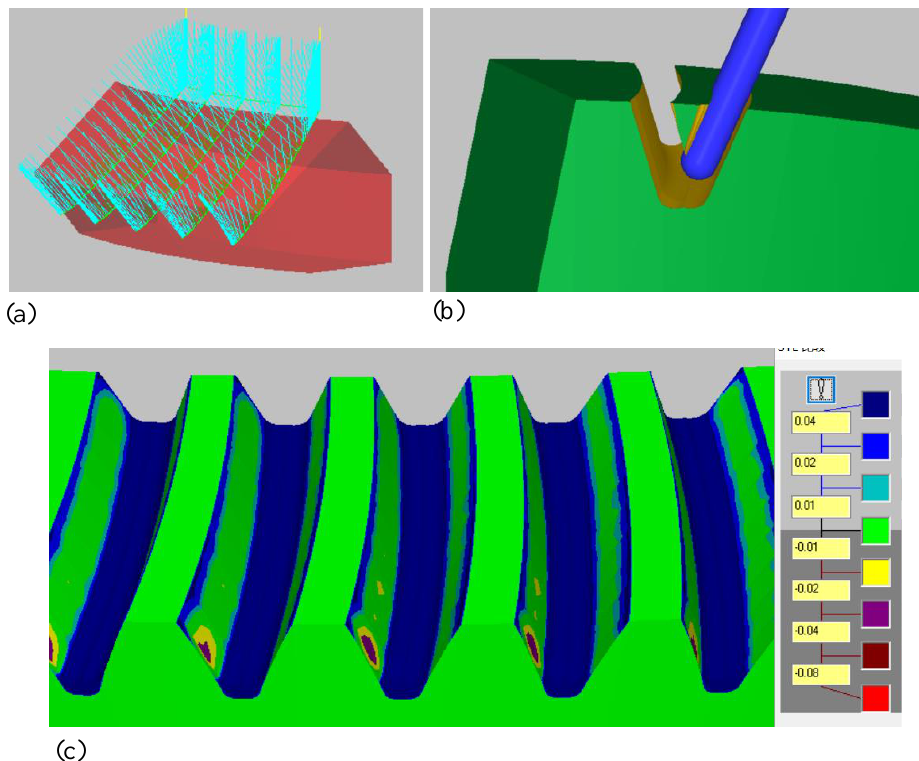
Figure 11. ( a ) Tool path generation by simulation; ( b ) simulation machining of five-axis flank milling; ( c ) tooth surface errors between simulated machining tooth surface and theoretical tooth surface.